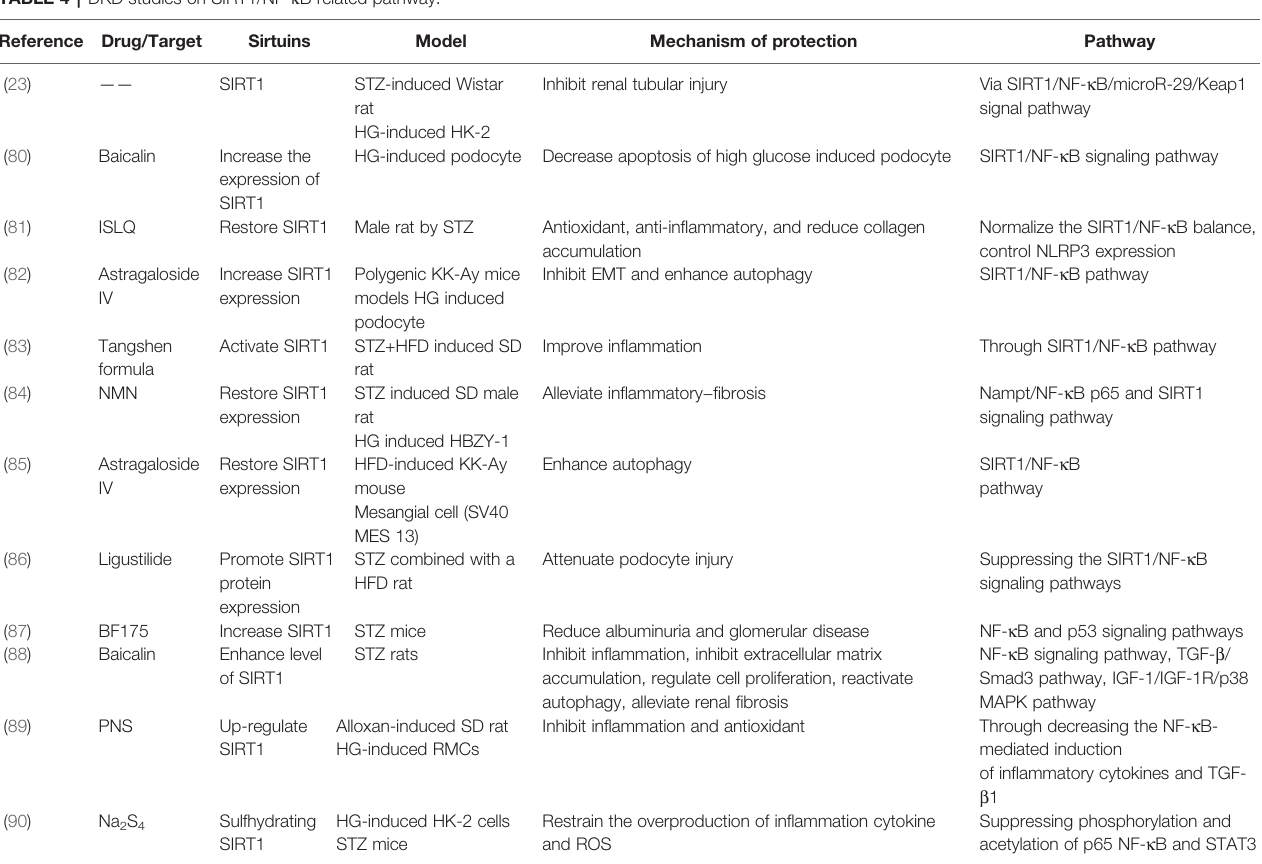
TABLE 4 | DKD studies on SIRT1/NF- k B related pathway. Reference